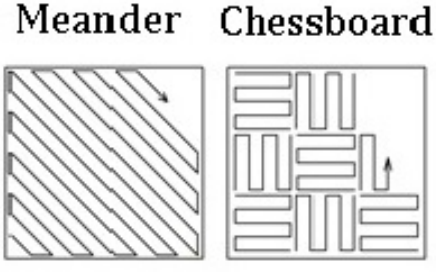
Figure 1. ( a ) selective laser melting (SLM)-prepared rectangular stainless steel sample 5 and ( b ) SLM-prepared cylindrical stainless steel sample 2.